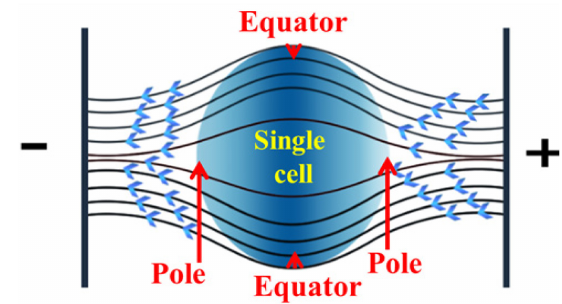
Figure 2. Electric field distribution for single cell electroporation where induced transmembrane potential is maximum at the cell pole and minimum at the equator.